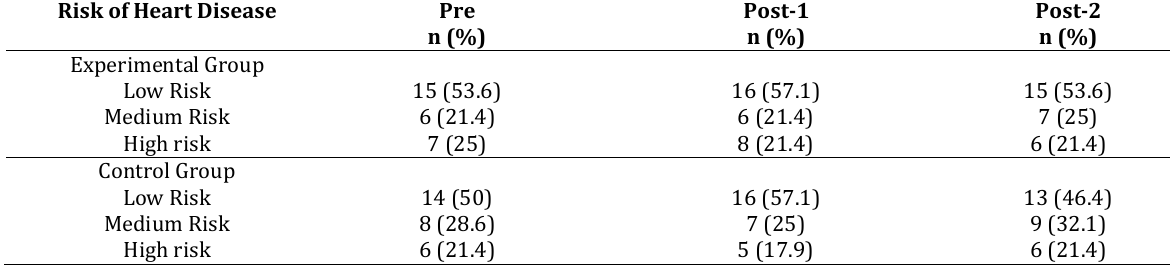
Table 8. The result of Friedman's test analysis score of the risk of heart disease in the experimental group